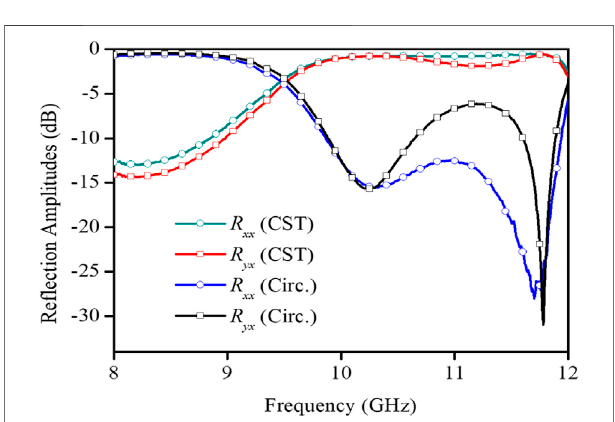
FIGURE 5 | Re fl ection amplitudes from the CST simulation and equivalent circuit